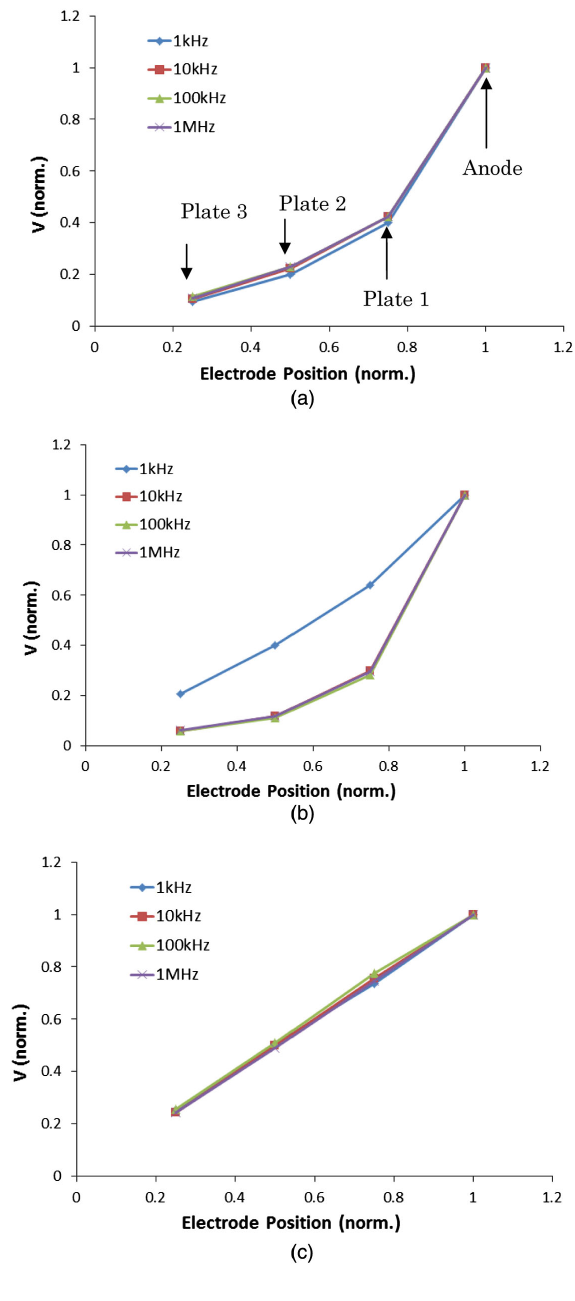
FIG. 11. (a) Measured voltage distribution in the case of no resistors. (b) Measured voltage distribution in the case of R ¼ 1 M(cid:1) . (c) Measured voltage distribution in the case of R ¼ 500 (cid:1)